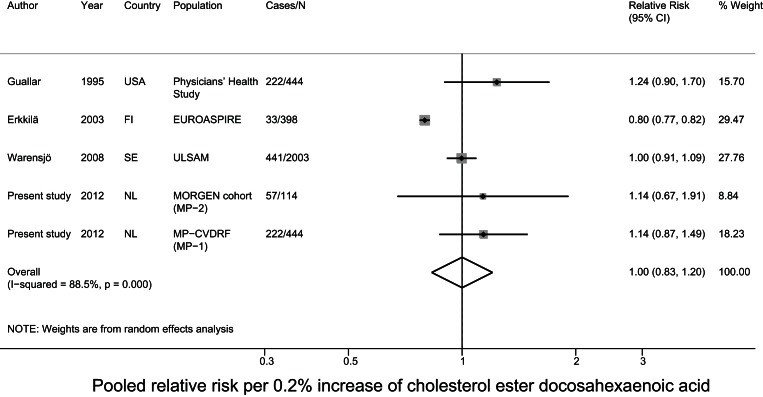
Pooled relative risk of cholesterol ester docosahexaenoic acid and CHD risk.